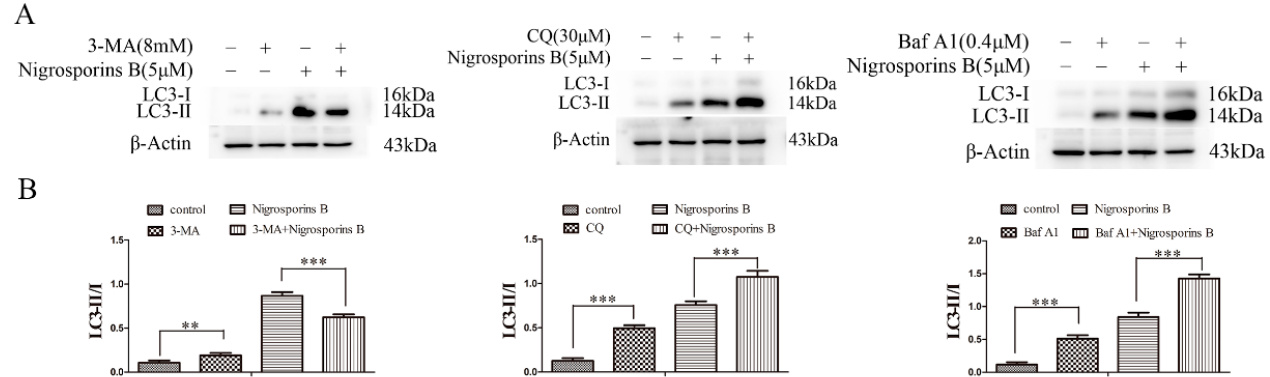
Figure 9. Nigrosporins B combined with autophagy inhibitors affected autophagy of Ca Ski cells, cells were treated with autophagy inhibitors for 6 h, then treated with Nigrosporins B for 24 h. ( A ) Nigrosporins B combined with or without 3-MA, CQ and Baf A1 affected the expression of LC3-II/LC3-I; ( B ) Protein expression of LC3 II/ I (** p < 0.01, *** p < 0.001).